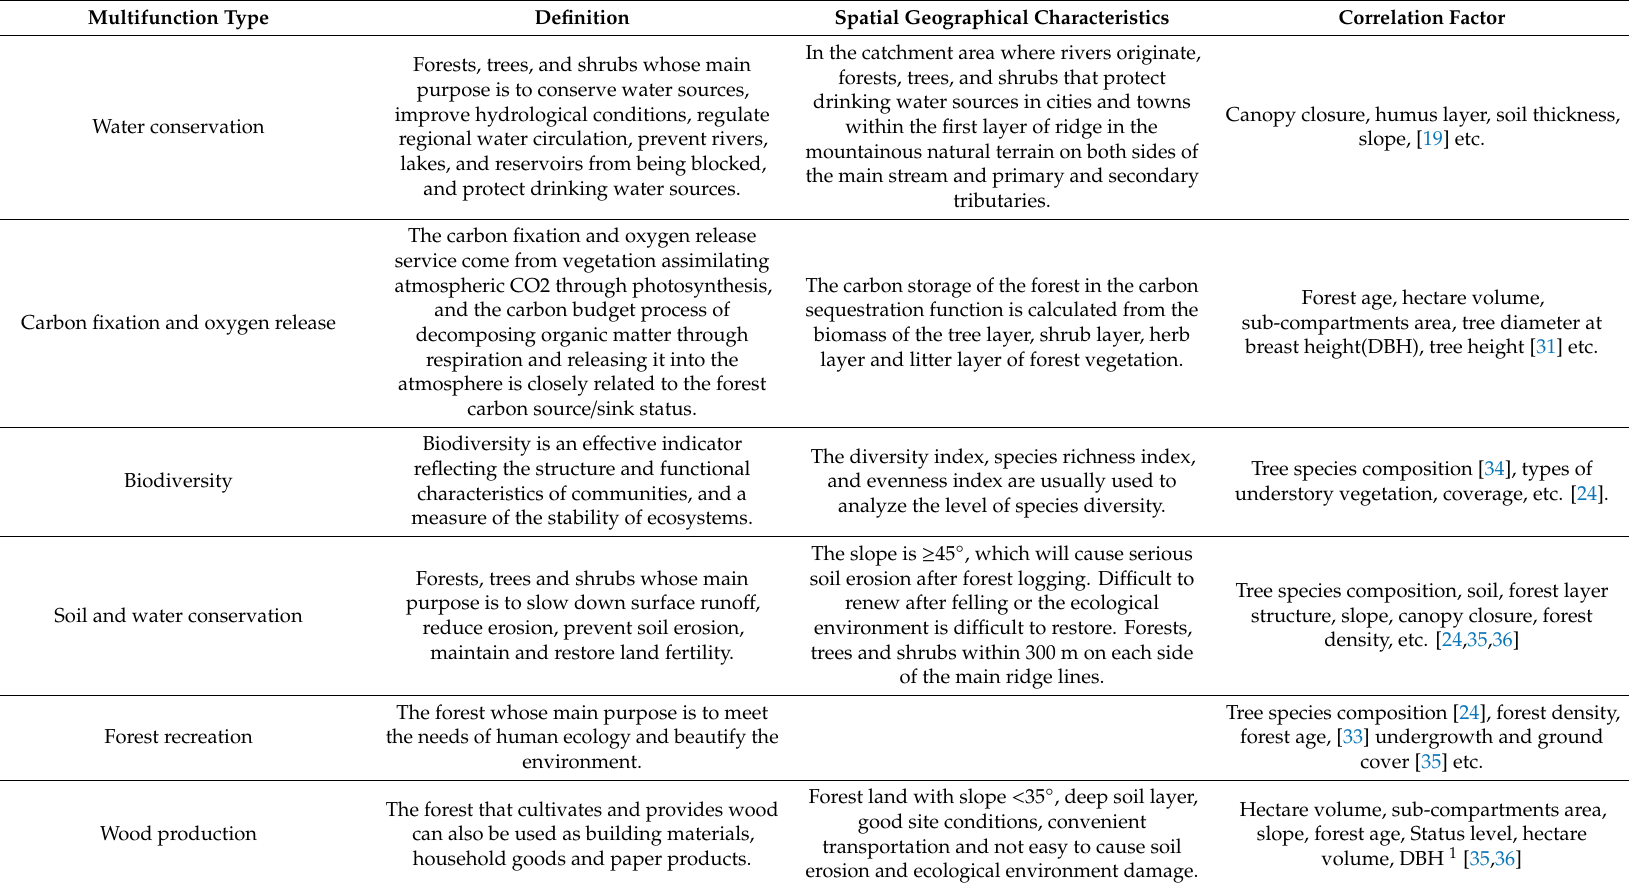
Table 1. Forest multifunctional types, geographical distribution of each function, and related site influence